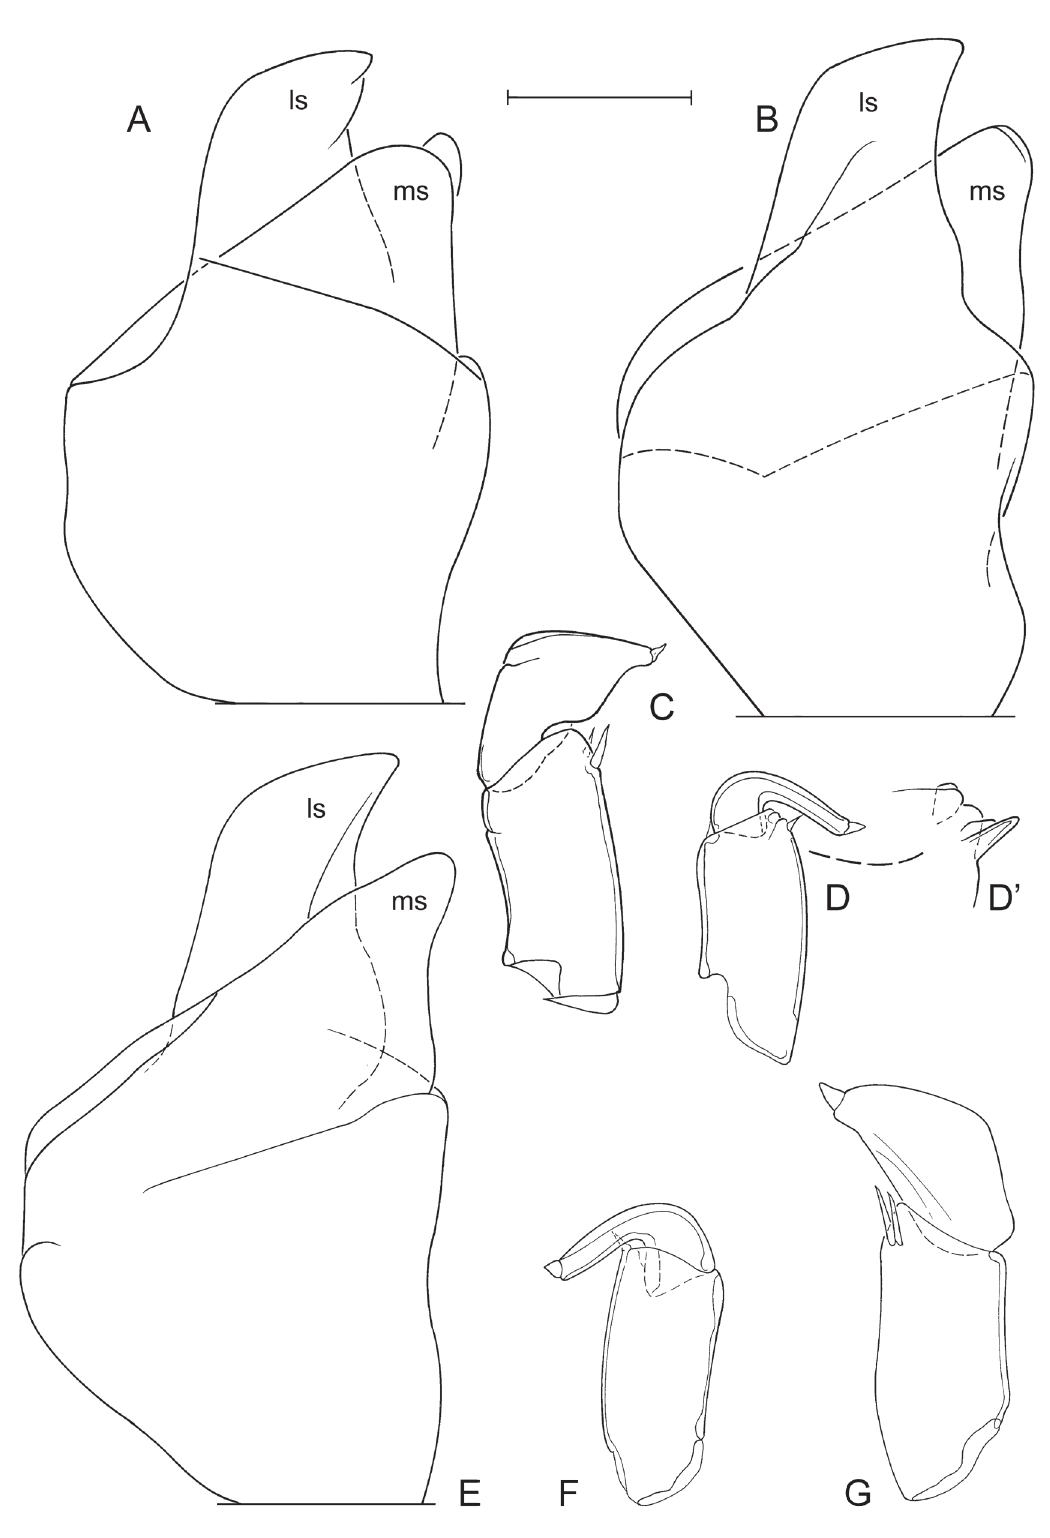
Fig. 11. Bennelongia timmsi sp. nov., non-type males. — A-D . Grahams rock (WaMc52240, BVt/10/02): A . Hemipenis. B . Hemipenis. C . right prehensile palp. D . left prehensile palp. D’ . Idem, detail of ventro-apical part of first segment. — E-F . King rocks (WaMc52252, BVt/10/06): E . Hemipenis. F . left prehensile palp. G . right prehensile palp. scale: a-G = 92 µm; D’ = 37